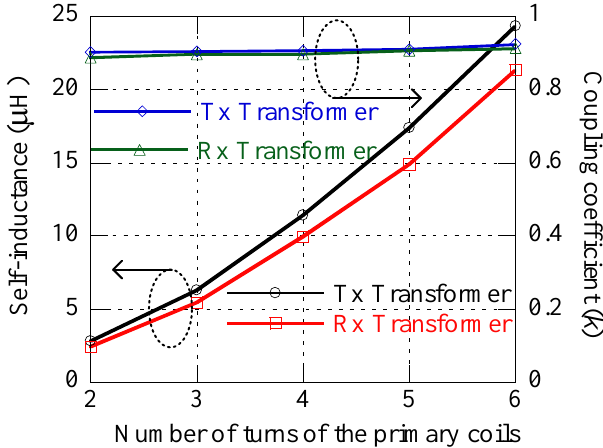
Figure 6. Coupling coefficients and self-inductances of the primary coils depending on the number of turns.